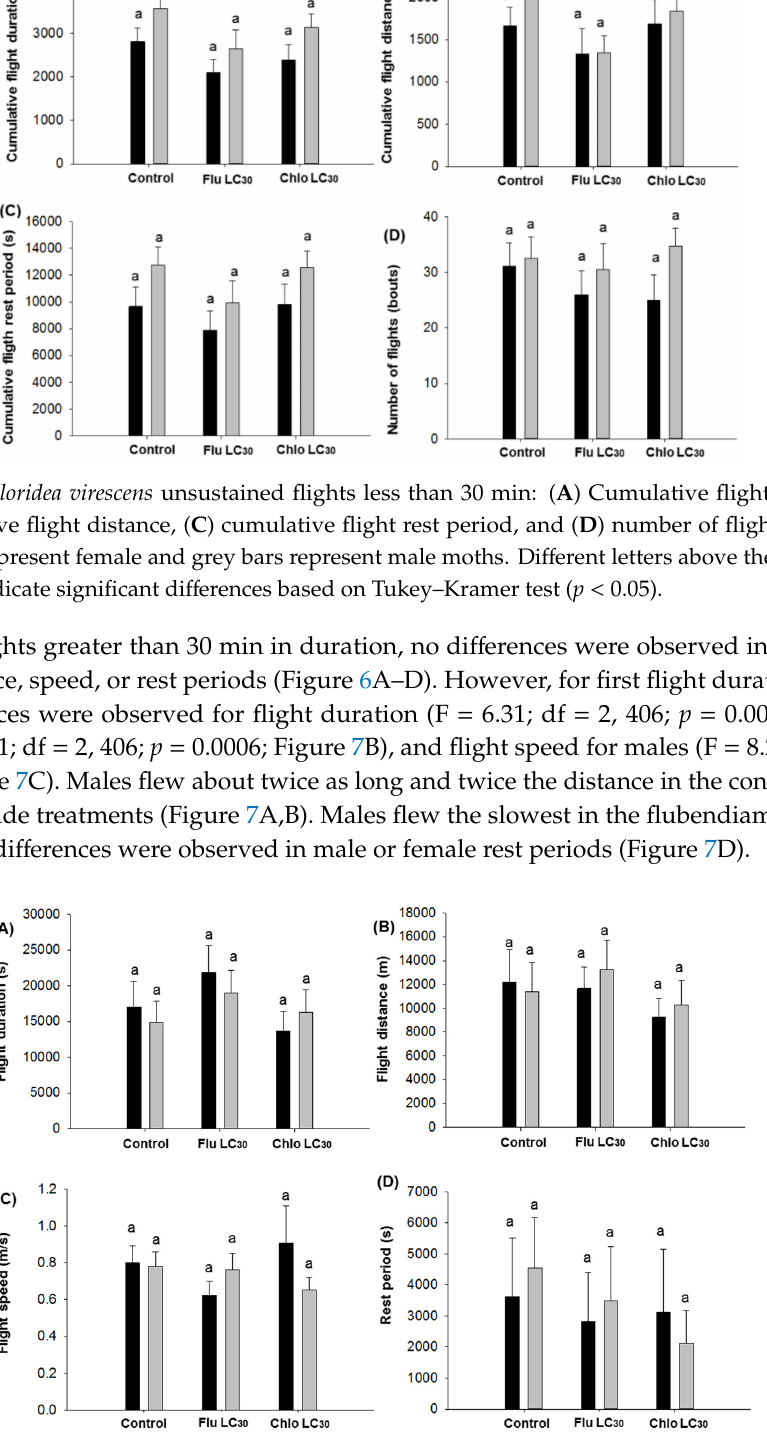
Figure 6. First flight taken by Chloridea virescens greater than 30 min: ( A ) Mean flight duration, ( B ) mean flight distance, ( C ) mean flight speed, and ( D ) mean rest time. Black bars represent female and grey bars represent male moths. Di ff erent letters above the standard error bars indicate significant di ff erences based on Tukey–Kramer test ( p < 0.05).